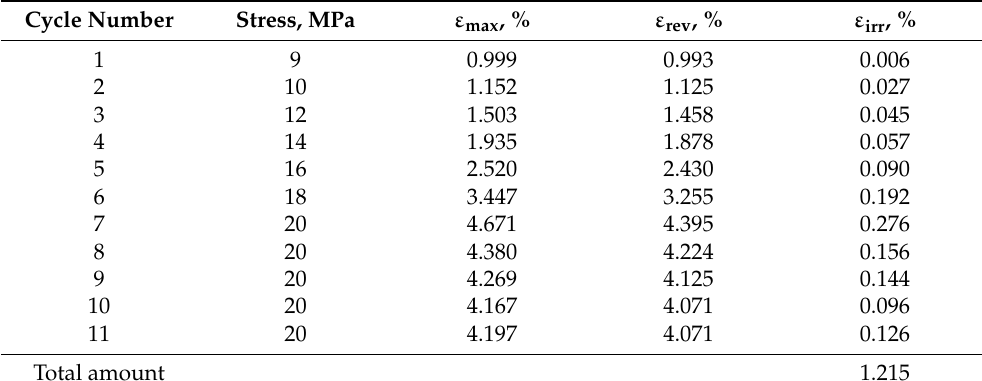
Table 3. Resultant strain achieved during